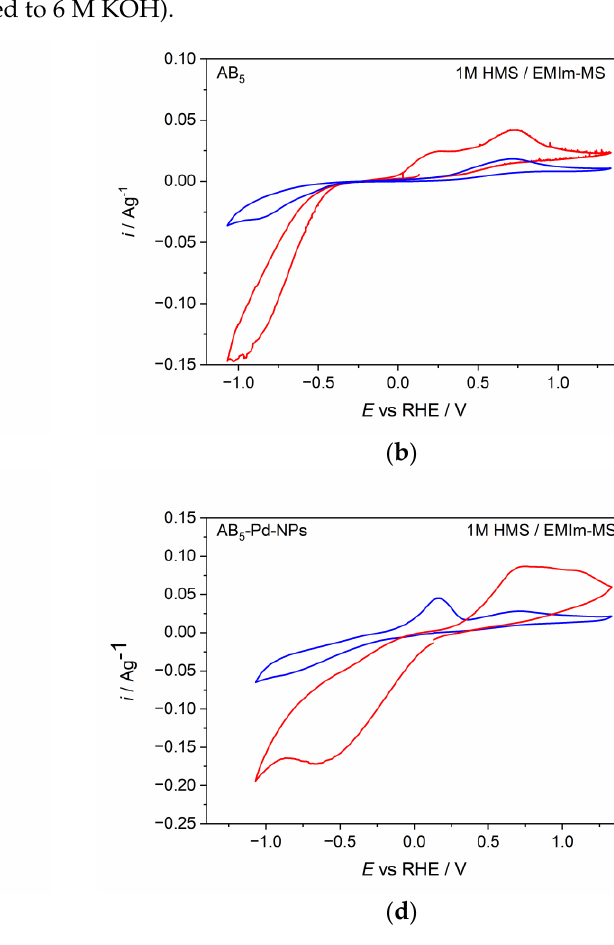
Figure 2. Cyclic voltammetry behavior of ( a ) AB 5 in DEMA-TFO ( b ) AB 5 in 1 M HMS/EMIm-MS ( c ) AB 5 -Pd-NPs in DEMA-TFO (d) AB 5 -Pd-NPs in 1 M HMS/EMIm-MS. Blue line — first CV cycle; red line — after activation (ca. 50 CV/CP cycles).